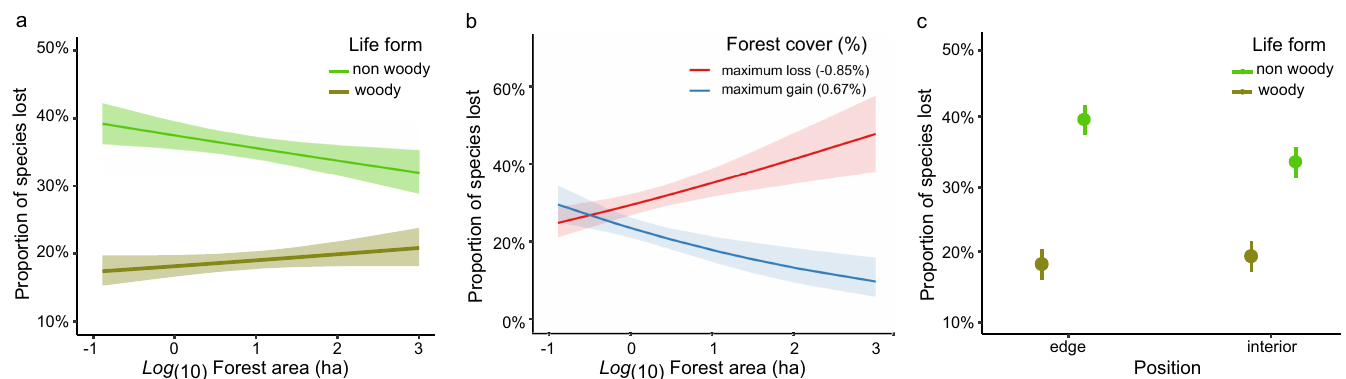
Fig 4. Proportion of species lost. Predicted probabilities and 95% confidence intervals for the marginal effect of three interaction terms on the proportion of species lost. a) Marginal effect of the log 10 of forest fragment area in relation to life form (non woody- woody), b) Marginal effect of the log 10 of forest fragment area in relation to maximum loss (red) and gain (blue) values of percent change in forest cover, c) Marginal effect of the position within the fragment (edge-interior) in relation to life form (non woody- woody).